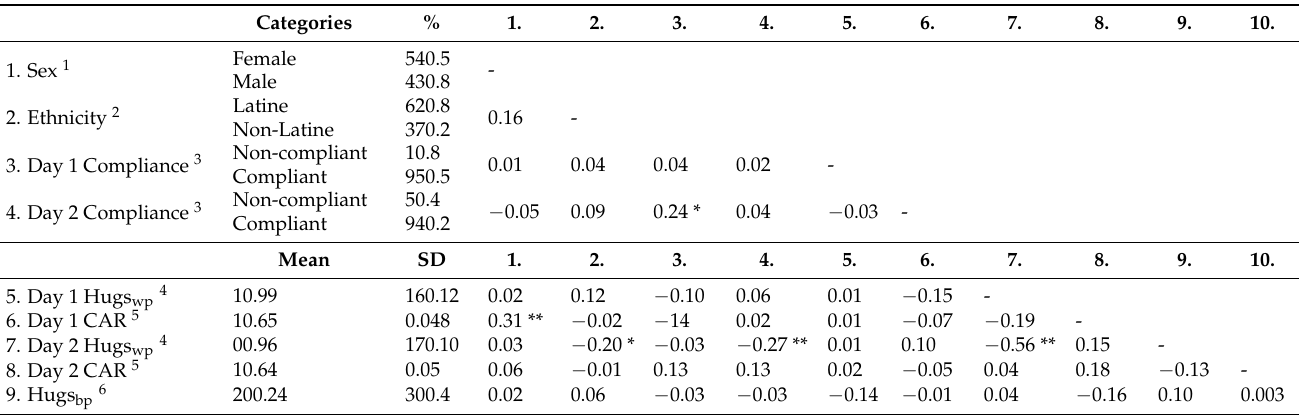
Table 2. Means, standard deviations, and correlations between